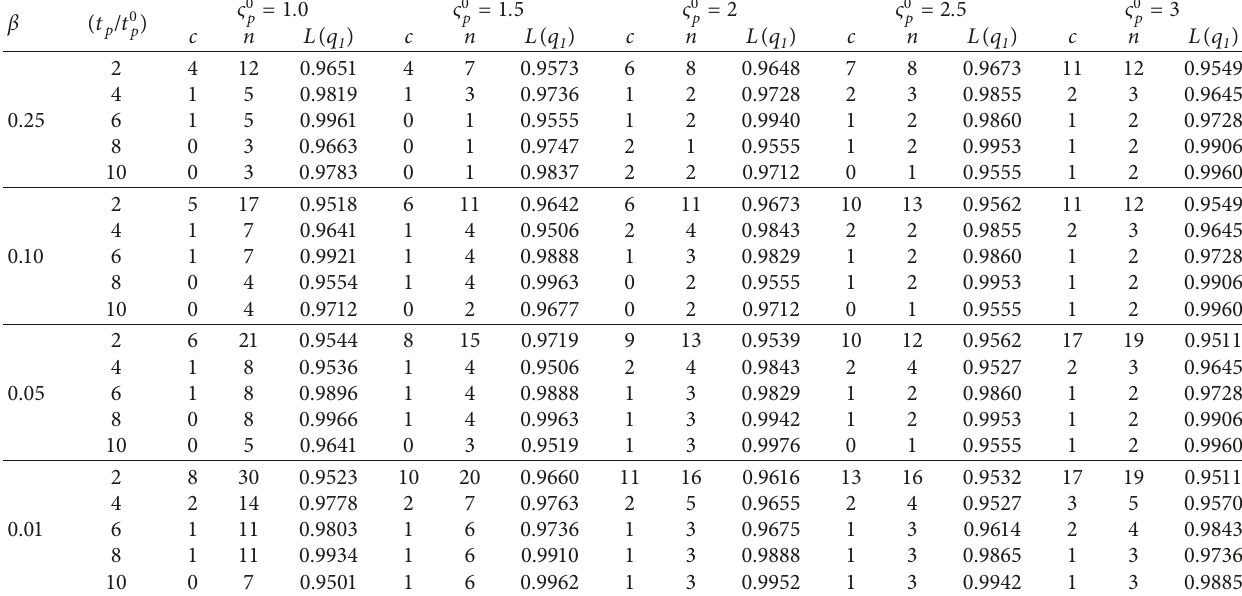
Table 3: The plan parameters and OC values for NGExp-Weibull distribution for φ � 2 , δ � 2, and k � 2.